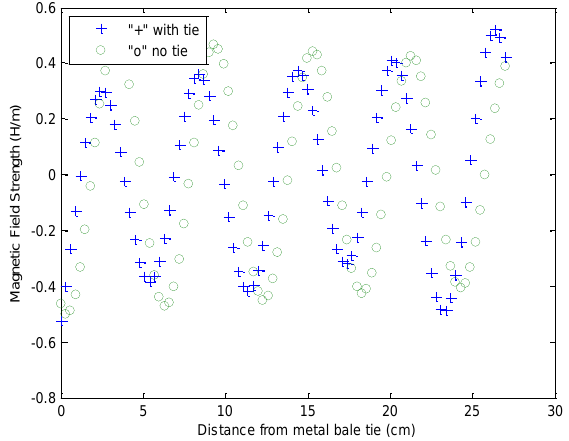
Figure 9. Comparison of the two test cases, with versus without wire-ties from the final steady-state FDTD simulation, illustrates both the magnitude and phase shift that occurs due to the